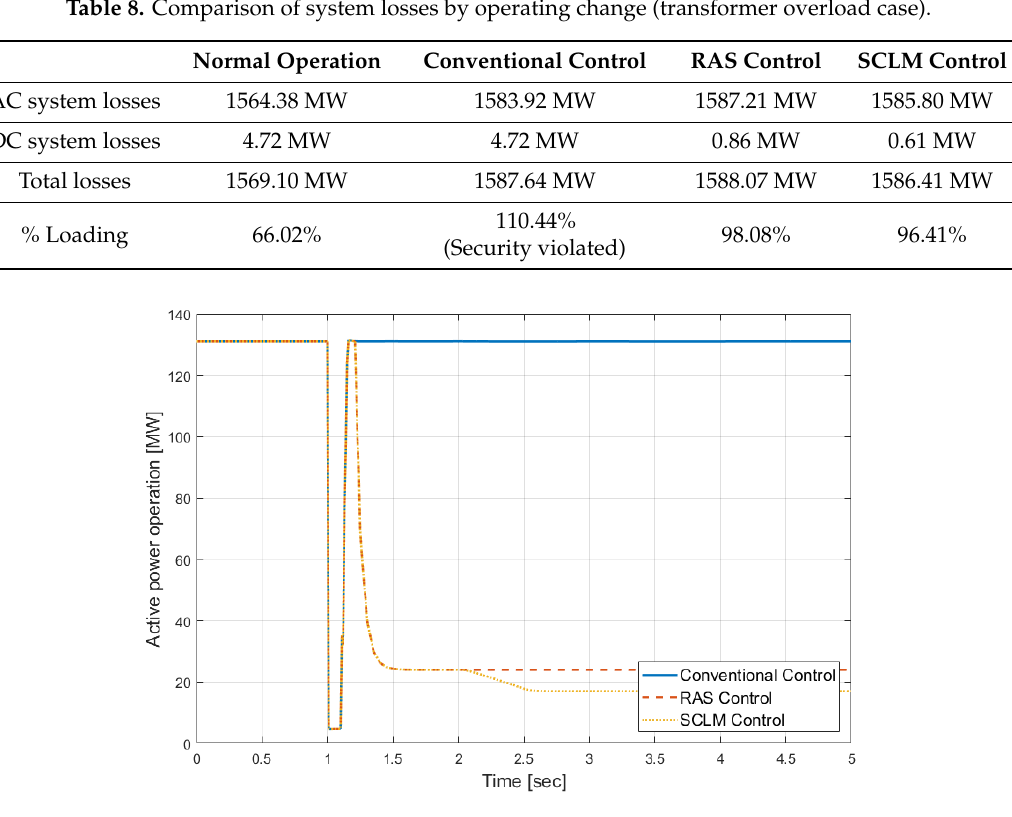
Table 8. Comparison of system losses by operating change (transformer overload case).